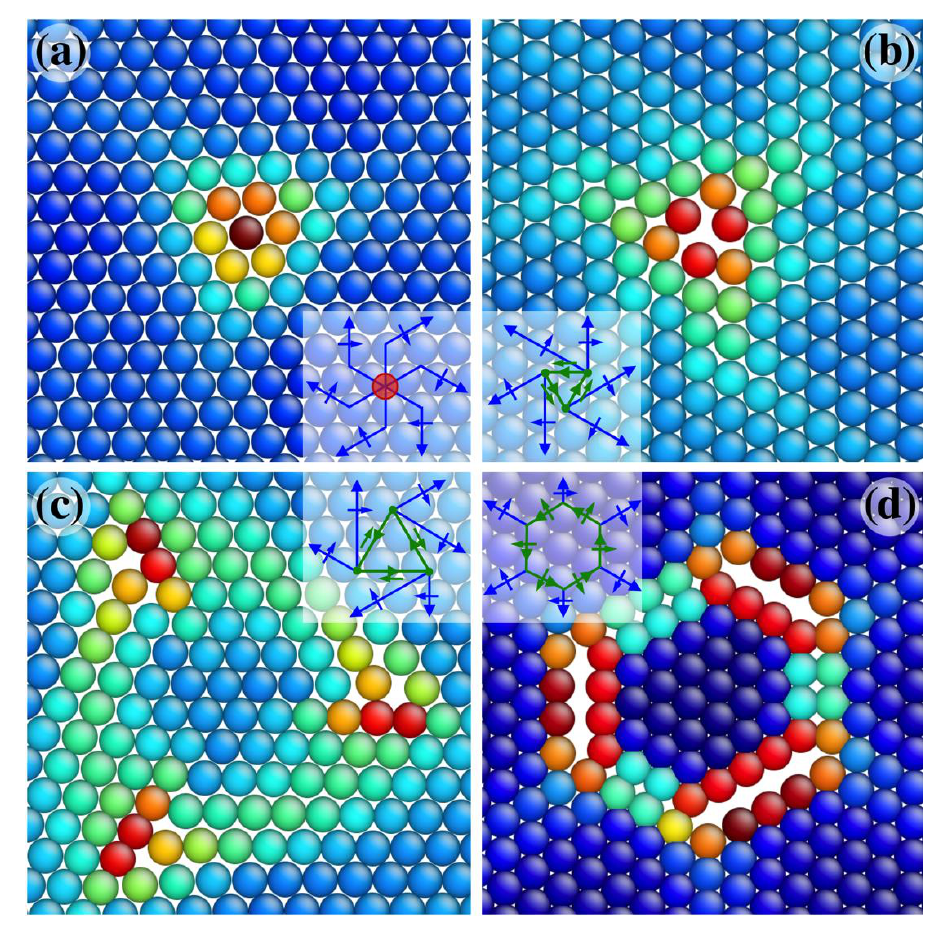
Figure 4. Various nodal structures associated with the redistribution of free volume, the dislocation structures of nodes are given in the insets. ( a ) Volume smeared node with spiral dislocation pattern; ( b , c ) the volume condensed nodes with triangular dislocation pattern; ( d ) the volume condensed node with hexagonal dislocation